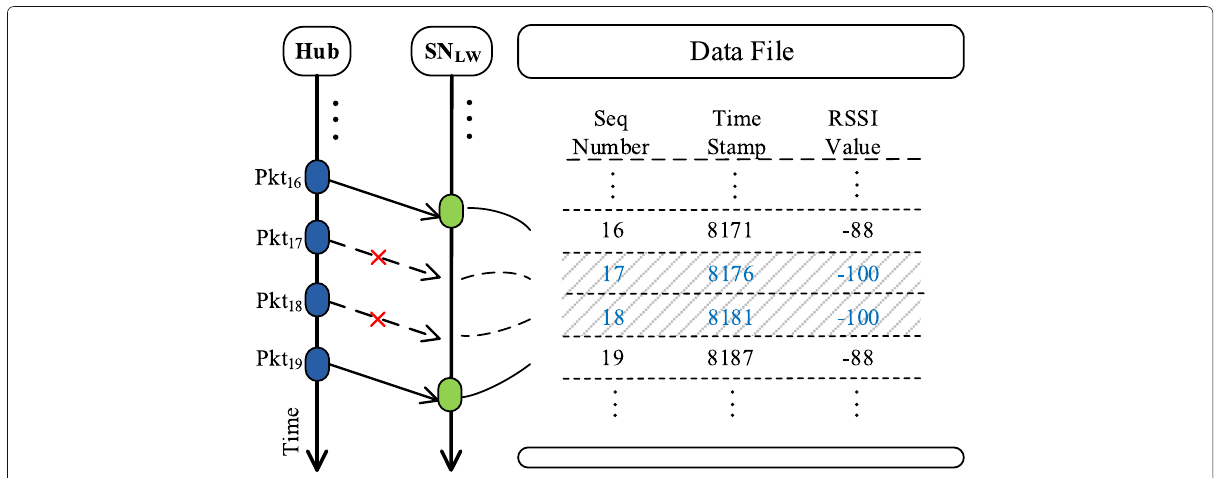
Fig. 3 Channel data recording when packets are lost